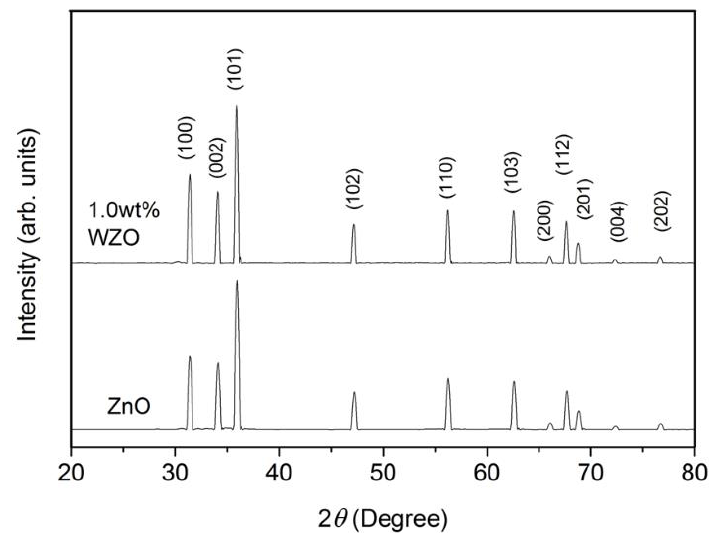
Figure 1. XRD patterns of pure ZnO and 1.0 wt.% WZO targets.